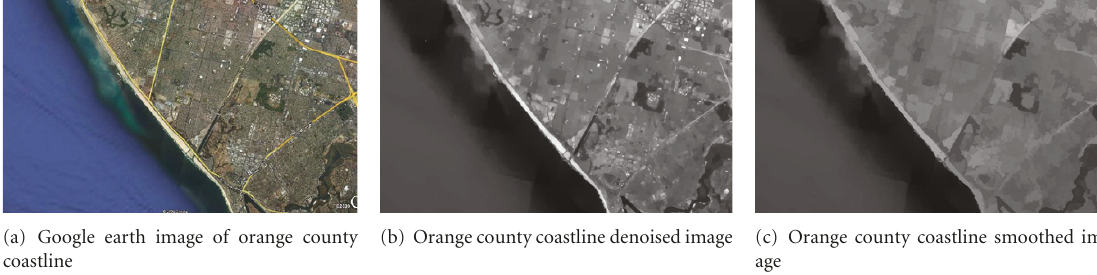
Figure 4: This shows how we obtained our valid region for the Orange County Coastline example. Figure (a) is the initial aerial image of the region to be considered. The region of interest is about 15.2 km by 10 km. Figure (b) is the denoised version of the initial image. We took this denoised image and smoothed away from regions of large discontinuities to obtain figure (c).